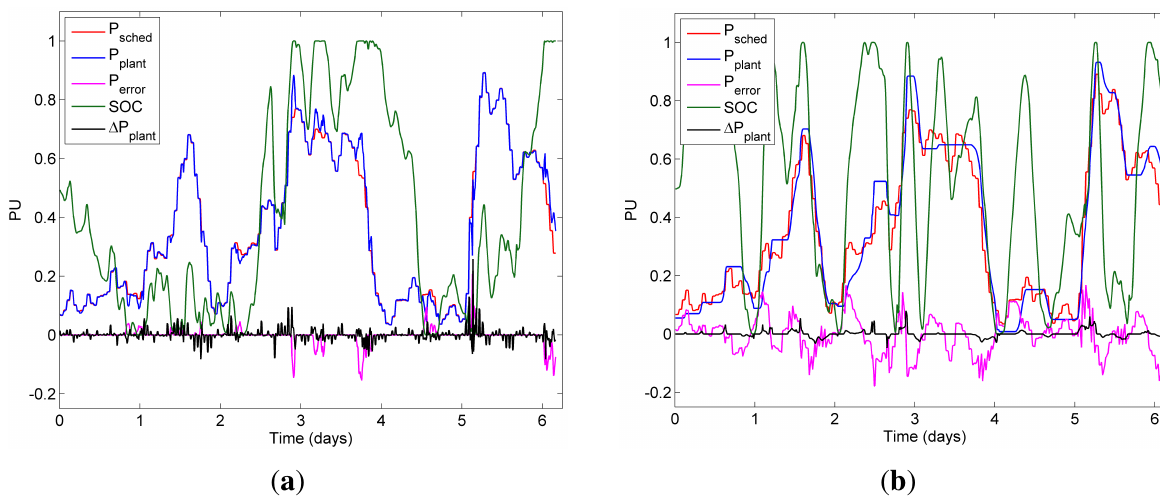
Figure 5. Simulation results for: ( a ) Case 3 with ∆ P plotted; in this case, only P plant weighted; minimizing ramps is not considered in the control action; and (b) Case 6; in this case, only ∆ P is weighted; ramps are minimized in this case at the expense of P plant evident in the plateau shape of P plant